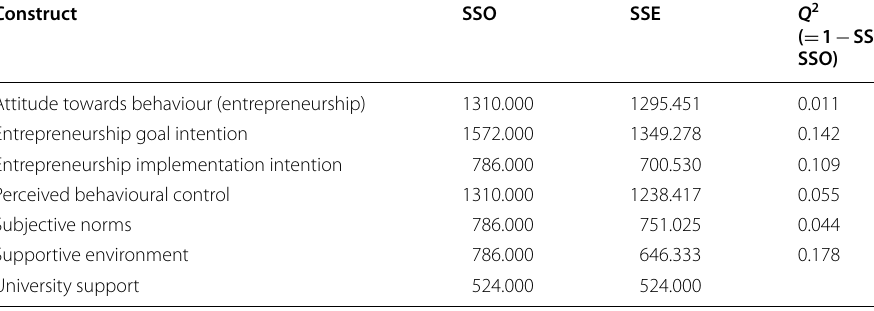
SSO mean value prediction, SSE prediction